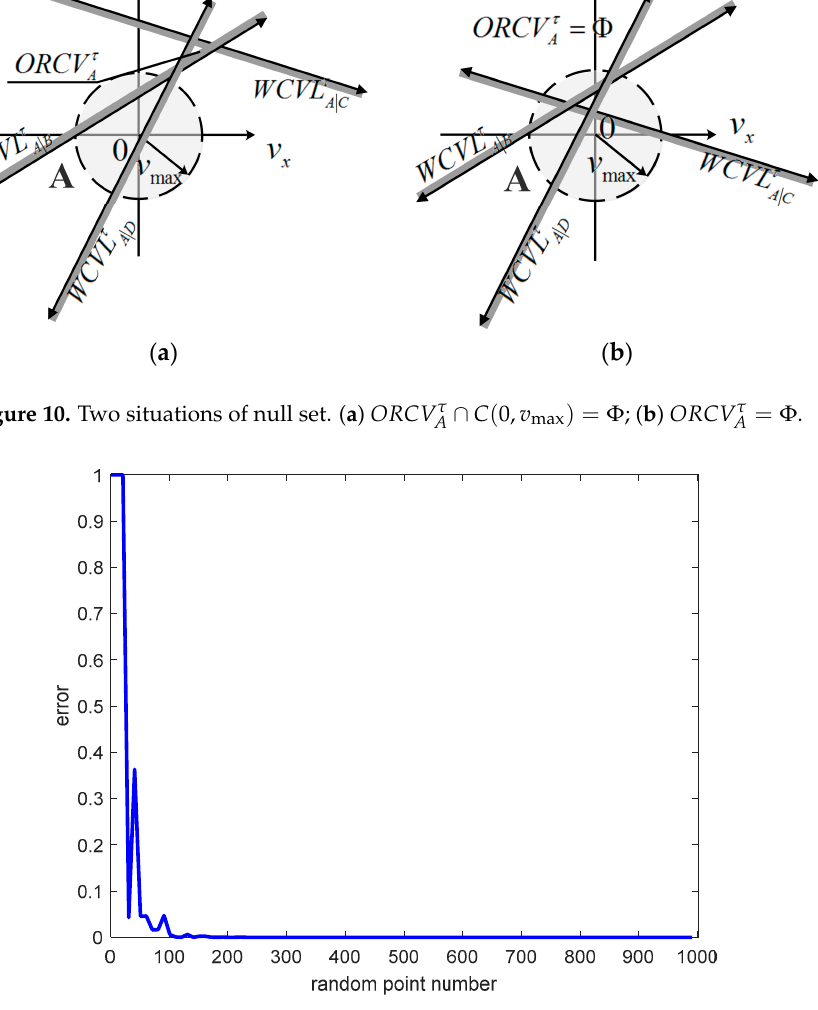
Figure 11. The probability of misjudgment of the null set with the number of random points.